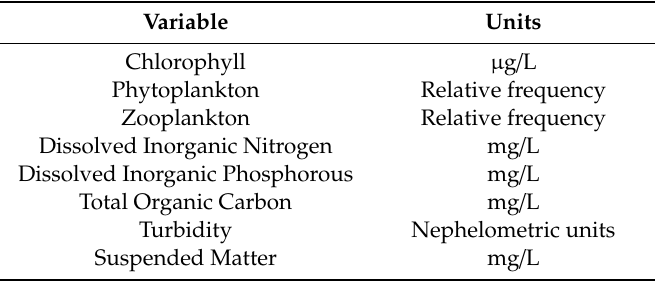
Table 3. Physicochemical variables obtained from Ebro’s Hydrographic Confederation (CHE, in Spanish), Tarragona’s Water Consortium (CAT, in Catalan), and Catalan Water Agency (ACA, in Catalan). Variable Units Chlorophyll